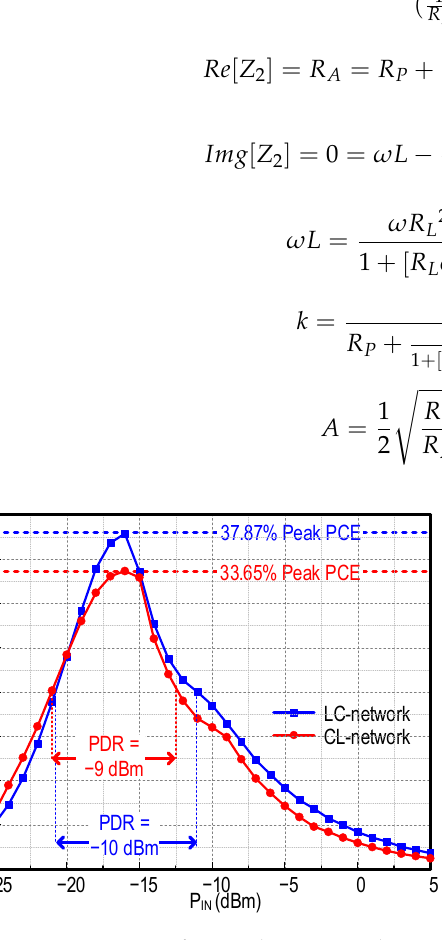
Figure 8. Four configurations of L-network: ( a ) Low pass CL for R S > R L , ( b ) High pass LC for R S > R L , ( c ) Low pass LC for R S < R L , ( d ) High pass CL for R S < R L .